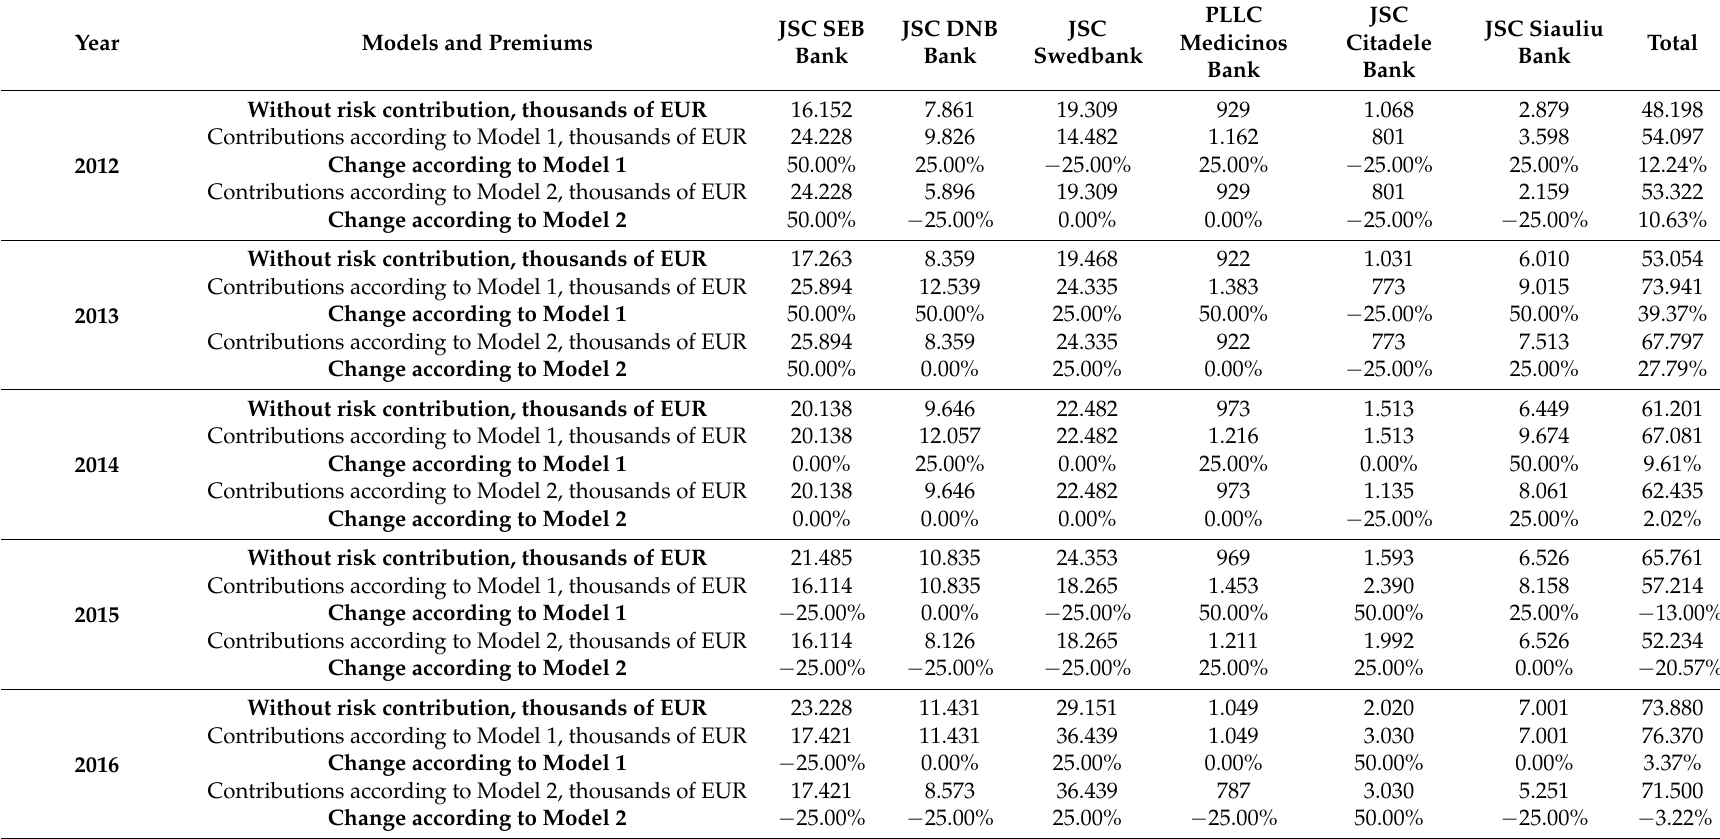
Table 8. A comparison of the Deposit Insurance Fund contributions of Lithuanian banks from Model 1 and Model